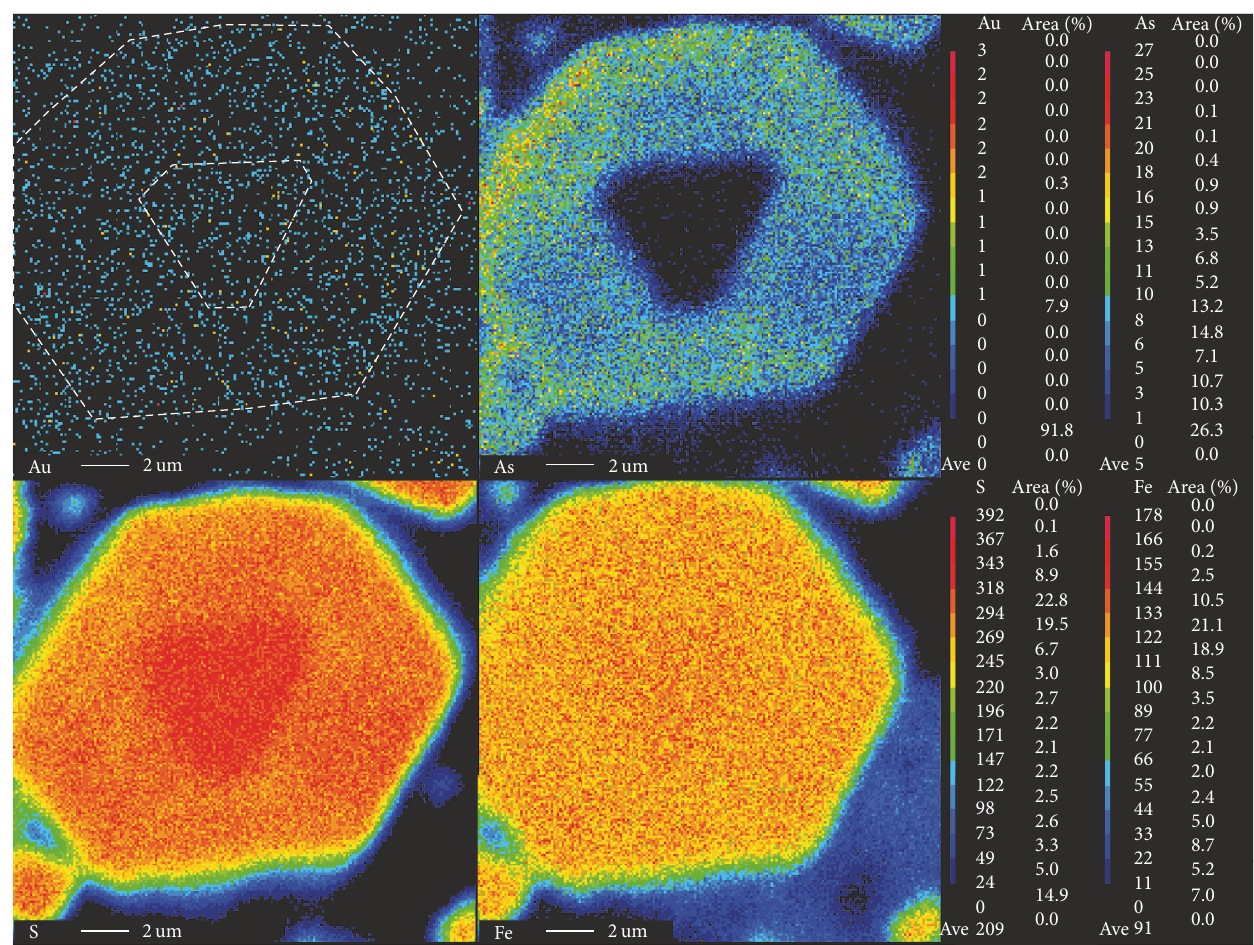
Figure 5: EPMA mapping of Au, As, S, and Fe in arsenian pyrite showing their distribution in the